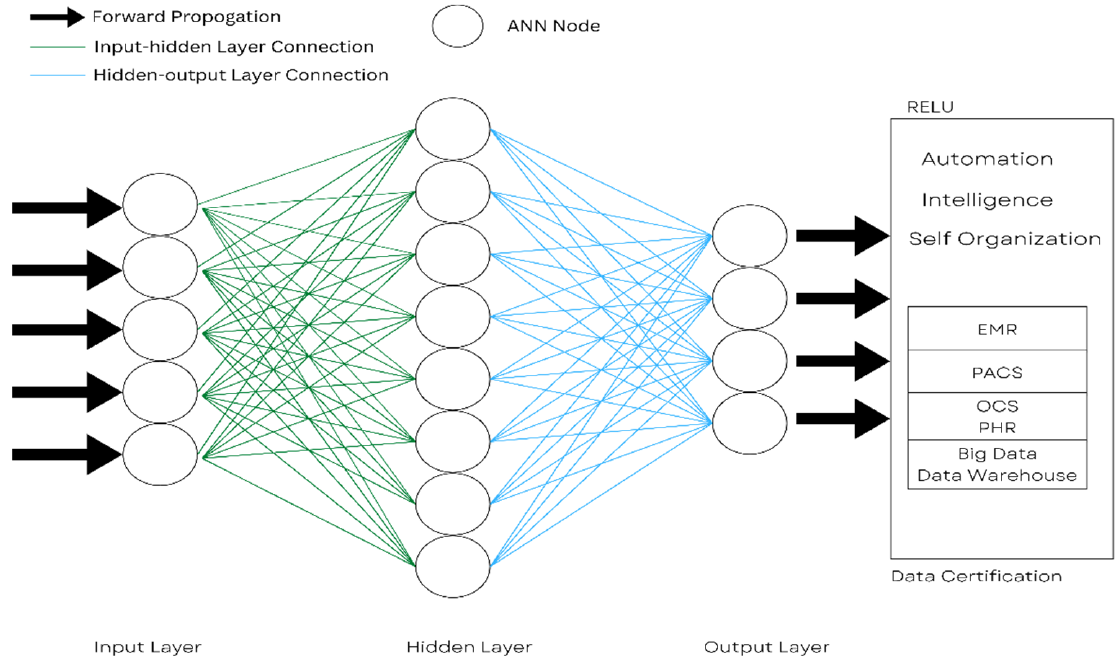
Figure 9. Concept of an artificial neural network for healthcare.